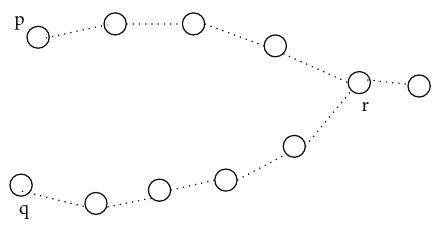
Figure 5: Nearest common ancestor of p and q is node